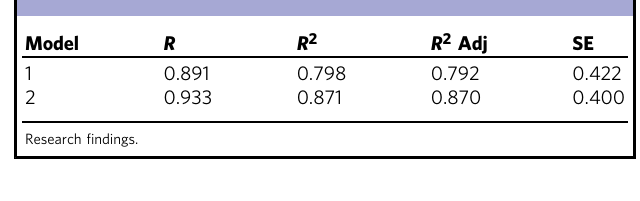
Table 9 Summary of multiple regression test model for predicting empowerment.